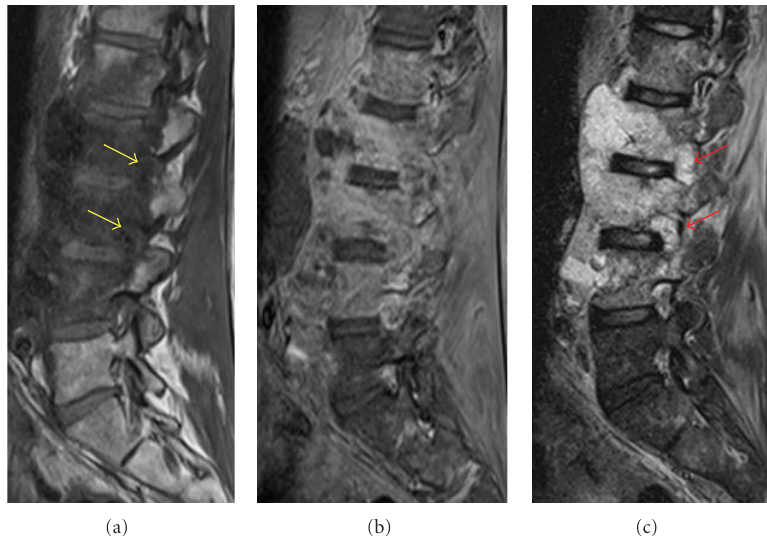
Figure 11: Sagittal T1-weighted MR image (a) shows abnormal hypointensity related to invasion by a paraspinal mass (spindle cell sarcoma). The cortical margins of the pedicles are attenuated (yellow arrows) in keeping with erosive changes of the mass invading through the neural foramina into the lateral epidural space. The postcontrast T1-weighted MR image with fat-saturation (b) shows heterogeneous enhancement of the mass. Marrow infiltration and neuroforaminal involvement (red arrows) is well seen as hyperintense signal on the STIR MR image (c).